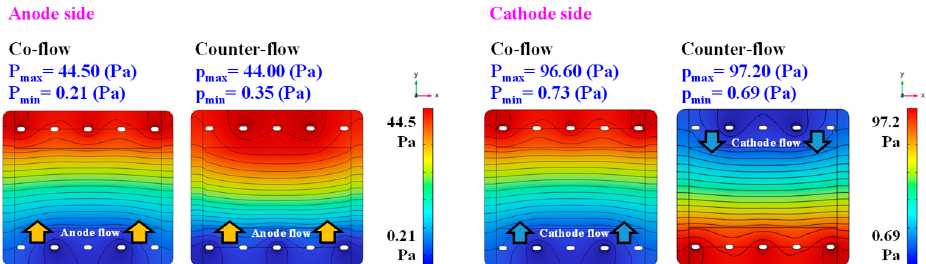
Figure 7. Pressure distribution at the anode and cathode side, according to the flow direction.